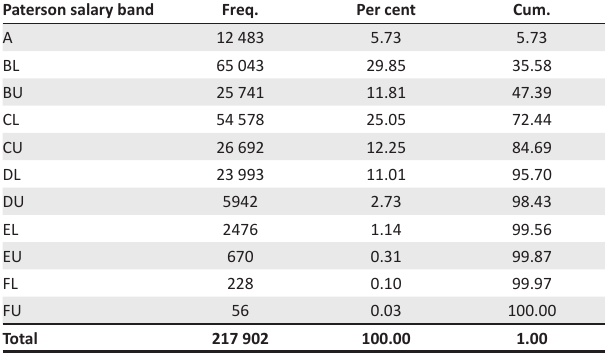
TABLE 2: Population frequency by salary